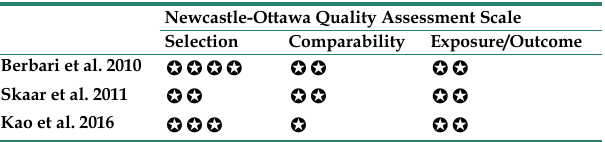
Table 2. Analysis of the methodological quality of case-control and cohort